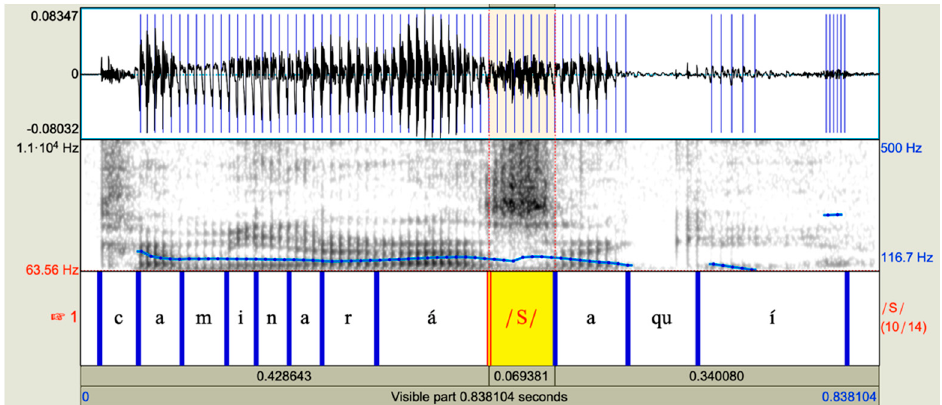
Figure 1. Younger L1-Catalan female rendition of la ca/z/a petita (‘the little house’) in Valencian Catalan (~9% voiced).